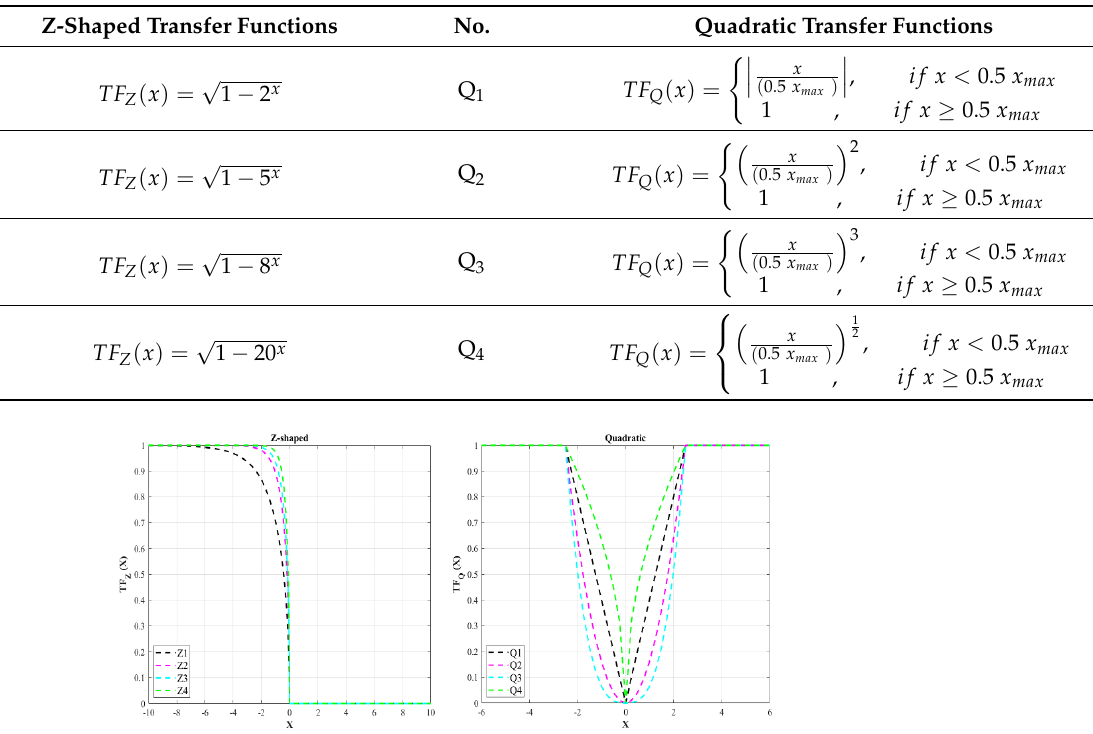
Table 2. The formulation of Z-shaped and quadratic family transfer functions.